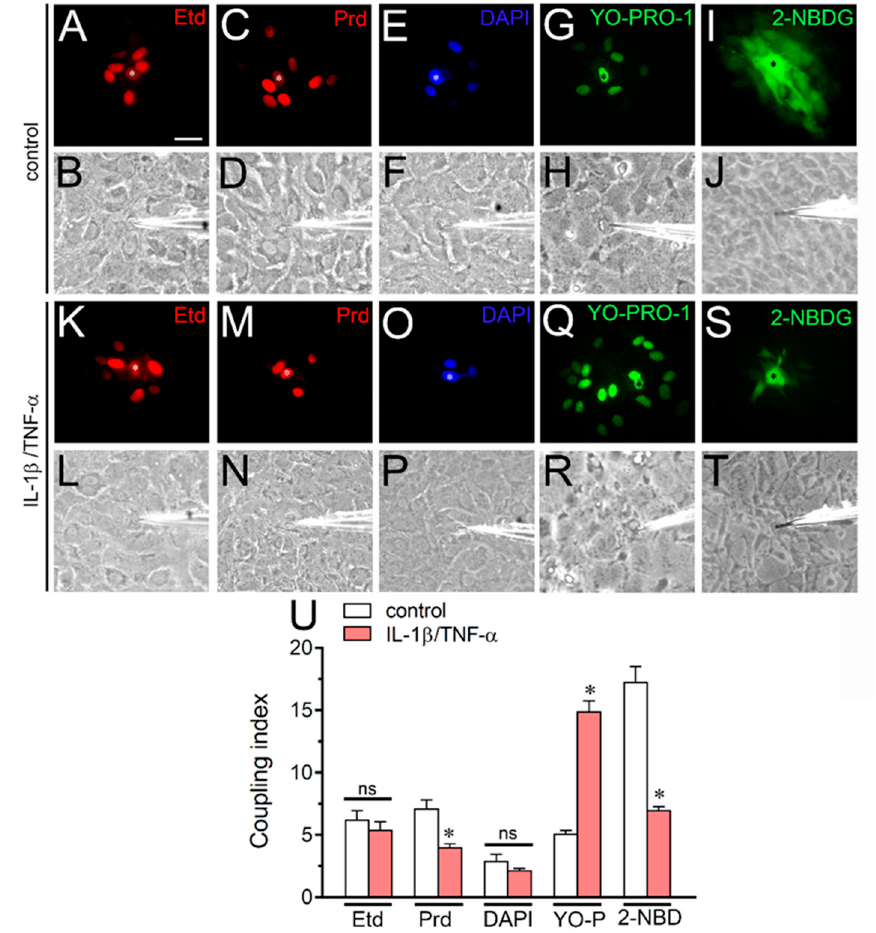
Figure 7. IL-1 β plus TNF- α changes the intercellular diffusion of permeant molecules via Cx43 gap junction channels depending on the permeant species in cultured astrocytes. ( A – T ) Intercellular diffusion of Etd ( A , K ), Prd ( C , M ), DAPI ( E , O ), YO-PRO-1 ( G , Q ) or 2-NBDG ( I , S ) by astrocytes under control conditions or stimulated with IL-1 β / TNF- α . In panels B, D, F, H, J, L, N, P, R and T are also shown the bright fields of each fluorescence picture. The * symbols indicate the injected cell. Calibration bar = 20 µ m. ( U ) Coupling index (number of cells coupled in positive injections) for Etd, Prd, DAPI, YO-PRO-1 or 2-NBDG by astrocytes under control conditions (white bars) or stimulated with IL-1 β / TNF- α (red bars). * p < 0.05, control vs. IL-1 β / TNF- α (two-way ANOVA followed by Tukey’s post hoc test). Data were obtained from at least three independent experiments with three repeats for each one ( ≥ 10 cells analyzed for each repeat).